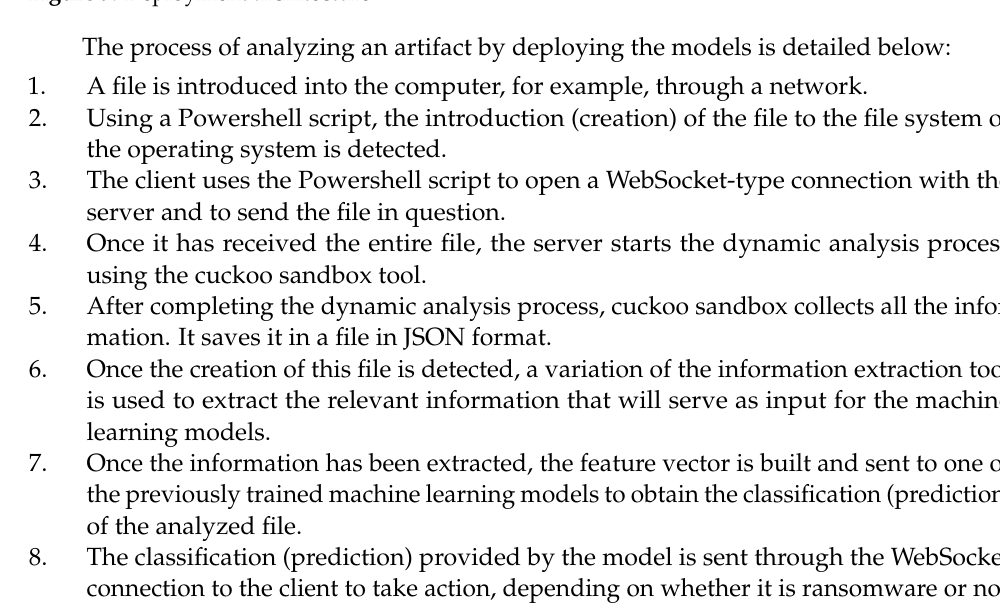
Figure 9. Deployment architecture.